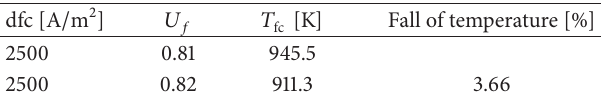
Table 4: Fall of temperature for increasing 𝑈 𝑓 for system with prereformer.